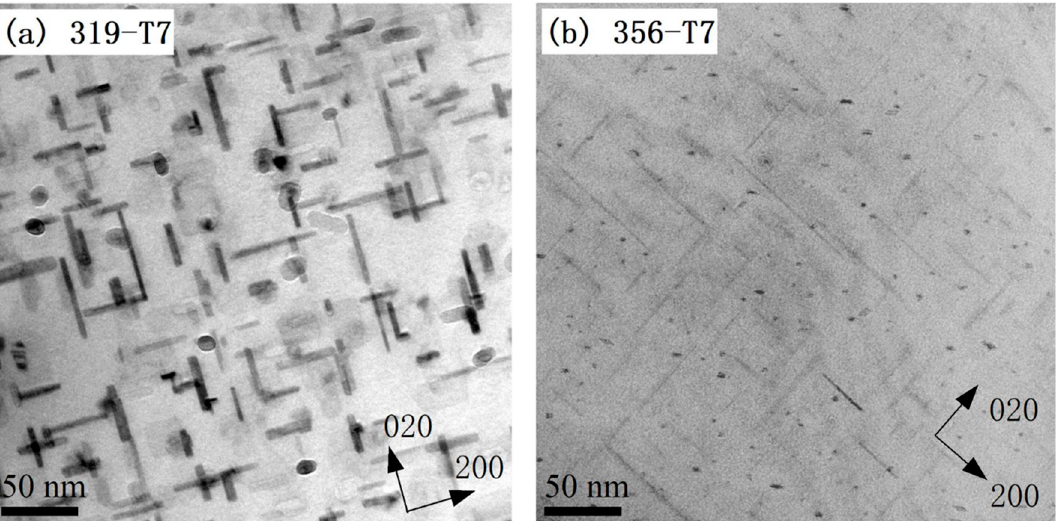
Figure 8. Bright-field TEM images showing precipitate microstructure after T7 (before TMF) for ( a ) θ ’-Al 2 Cu in the 319 alloy and ( b ) β ’-MgSi in the 356 alloy.